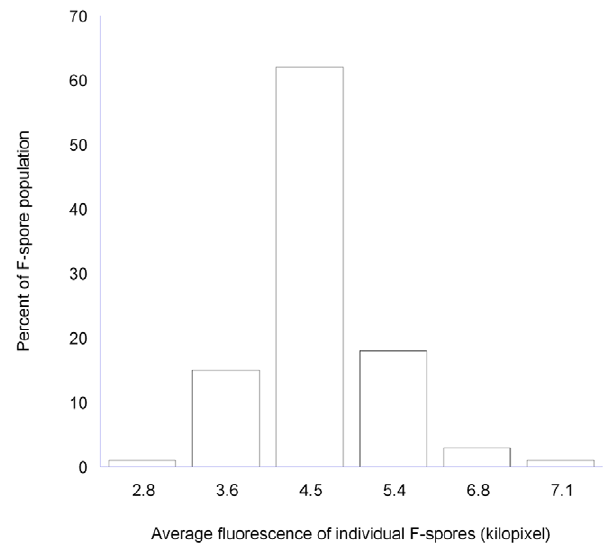
Figure 5. Distribution of fluorogenic functionality among F- spores. Histogram of fluorescence intensity among individual F-spores constructed with Syto 9. Fluorescent intensity was measured as indicated in Material and Methods.